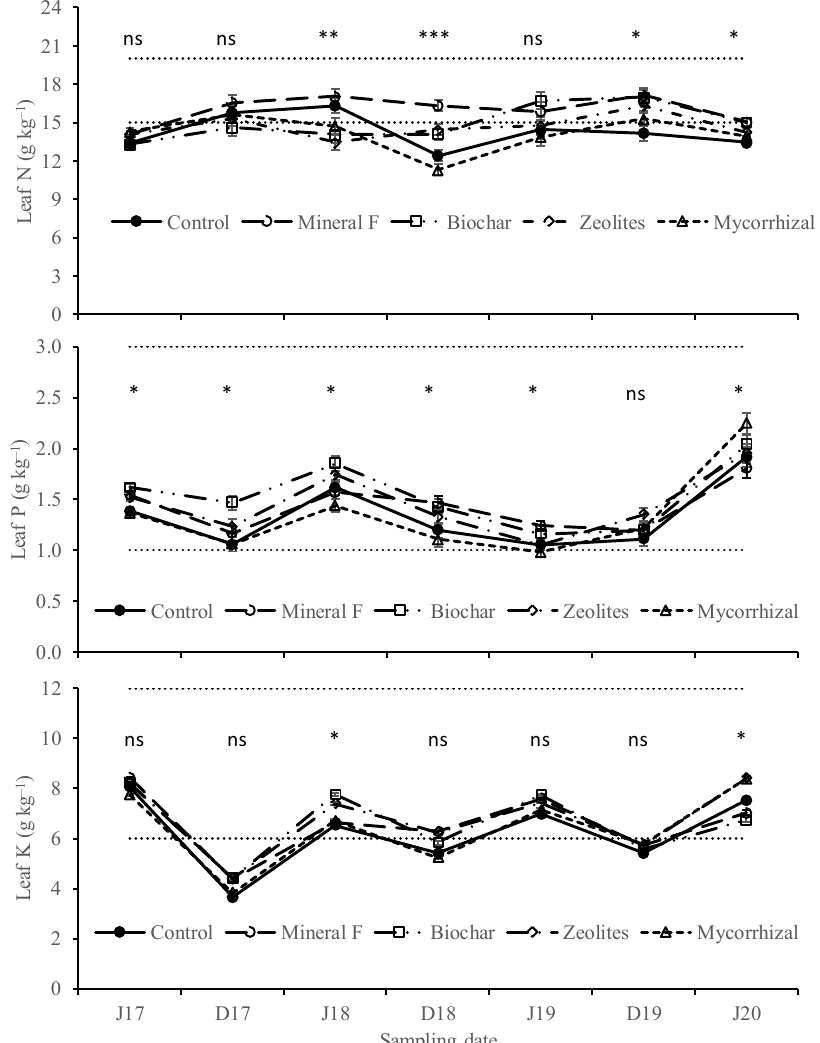
Figure 6. Leaf concentrations of nitrogen (N), phosphorus (P) and potassium (K) in seven consecutive samplings in July (J) and December (D) from July 2017 (J17) to July 2020 (J20). Horizontal dashed lines are the lower and higher limits of the sufficiency ranges; vertical bars the standard errors; ns (not significant), * ( p < 0.05), ** ( p < 0.01) and *** ( p < 0.001) are the results of analysis of variance.